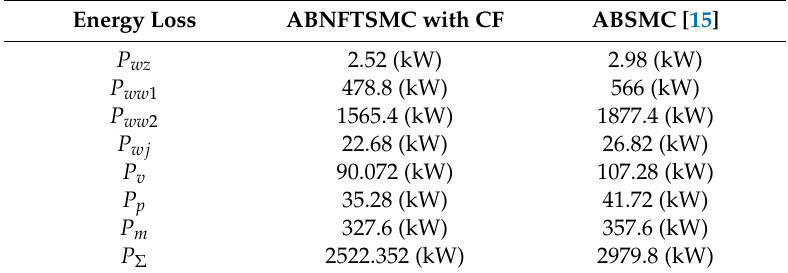
Table 1. The comparison of power losses under stochastic intensity D =